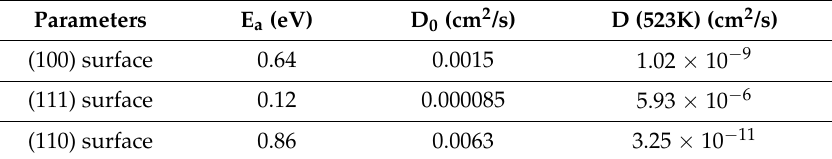
Table 3. Diffusion rates of different surfaces for gold at 250 °C [7].